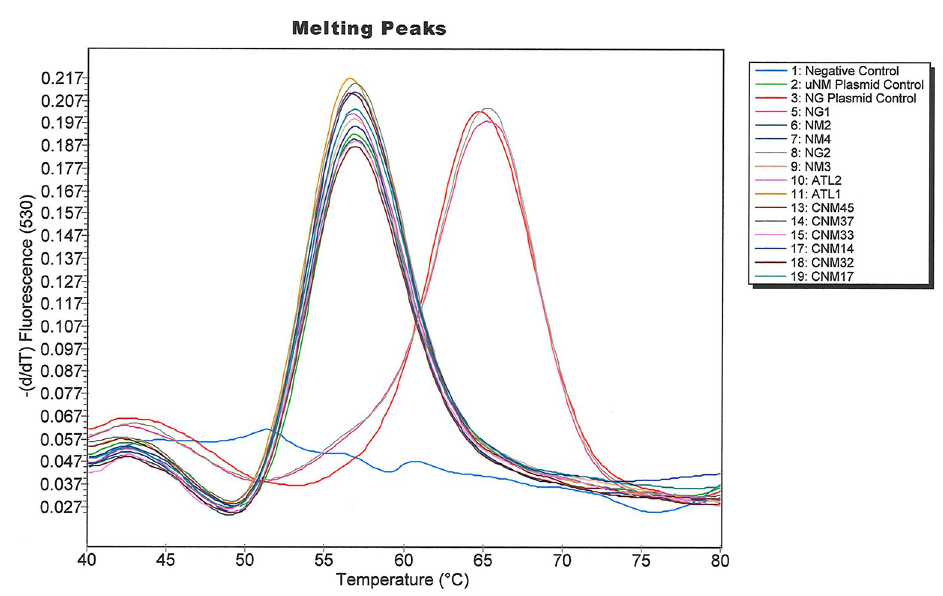
Fig 6. Amplification curves generated using a panel of US_NmUC isolates from geographically diverse case- clusters.